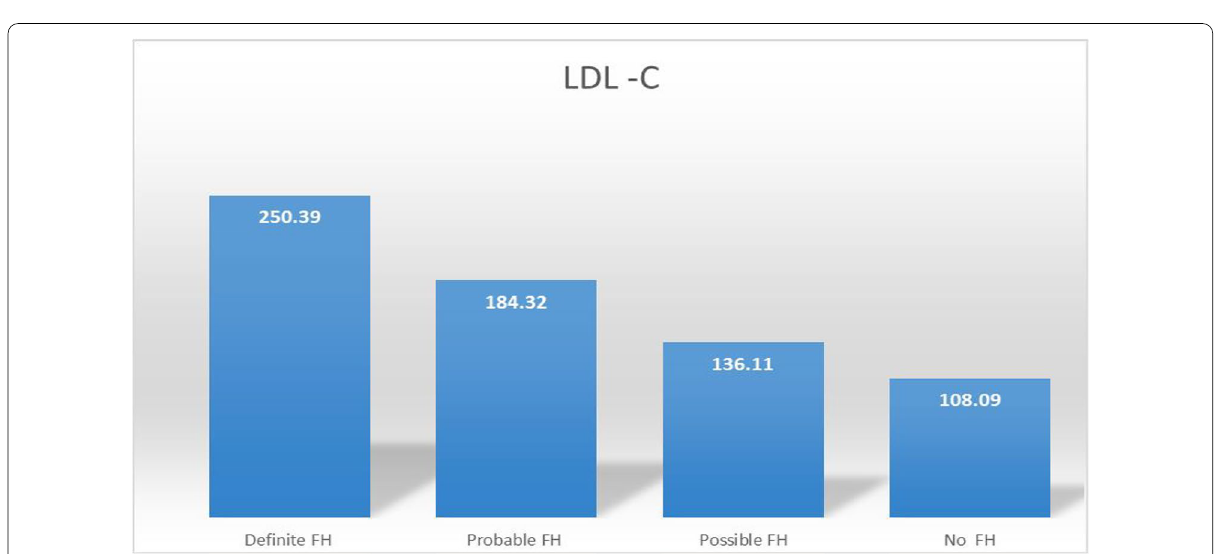
Fig. 3 The relation of the presence of mean LDL-C concentration in blood plasma with different types of FH patient groups. The maximum concentration was found in definite FH, and the minimum concentration was found who had no FH detected by DLCN criteria. This finding